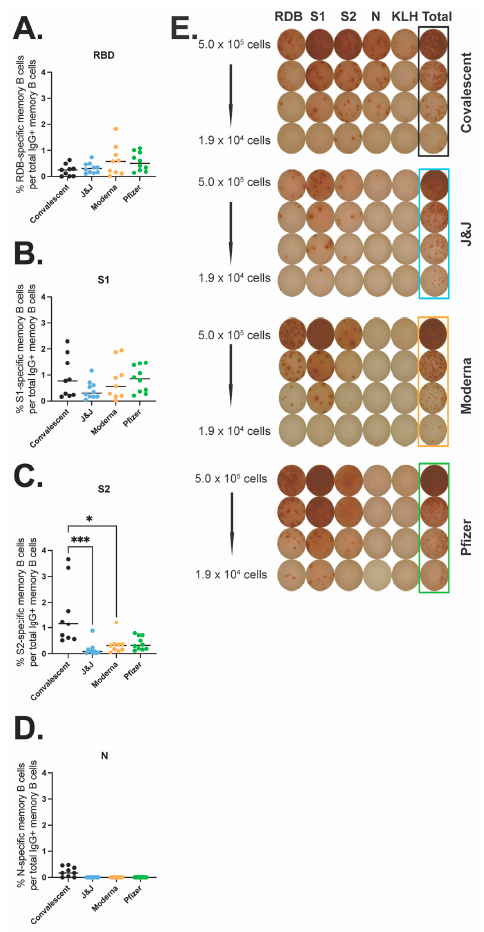
Figure 3. SARS-CoV-2 specific memory B cell responses after vaccination or natural infection. Antigen-specific IgG MBCs from the peripheral blood are shown as a percentage of total IgG-secreting MBCs for RBD ( A ), S1 ( B ), S2 ( C ), and N ( D ) for convalescent (black, n = 9), J&J (blue, n = 10), Moderna (orange, n = 9), and Pfizer (green, n = 10) participants. ( E ) Representative MBC ELISpot data, one participant from each group. PBMCs were stimulated with RBD, S1, S2, N protein, or KLH (negative control). * p < 0.05 and *** p < 0.001 by Kruskal–Wallis.